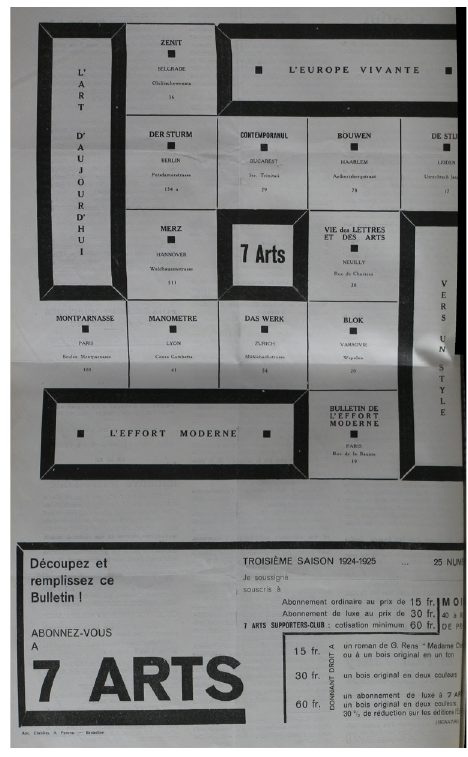
Fig. 15 7 Arts , 3d series, no. 18 (15 March 1925), 4.